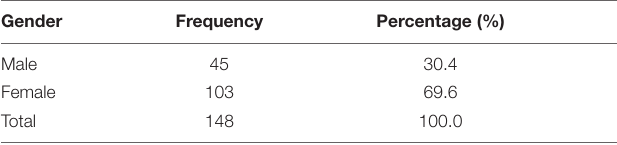
TABLE 5 | The frequency and percentages of male and female